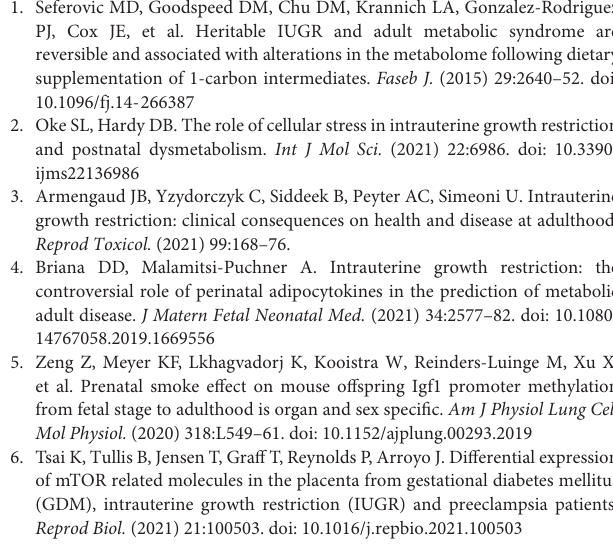
Supplementary Figure 2 | The GO enrichment analysis of the DEGs (RR_3_Mal vs. RC_3_Mal) in the cardiac muscle samples of the rats. (A) The GO enrichment analysis of upregulated DEGs in RR_3_Mal and downregulated in RC_3_Mal. (B) The GO enrichment analysis of downregulated DEGs in RR_3_Mal and upregulated in RC_3_Mal. Supplementary Figure 3 | The GO and KEGG enrichment analysis of the DEGs (RR_3_Mal vs. RR_9_Mal) in the cardiac muscle samples of the rats. (A) The GO enrichment analysis of upregulated DEGs in RR_3_Mal and downregulated DEGs in RR_9_Mal. (B) The GO enrichment analysis of downregulated DEGs in RR_3_Mal and upregulated DEGs in RR_9_Mal. (C) The KEGG enrichment analysis of upregulated DEGs in RR_3_Mal and downregulated DEGs in RR_9_Mal. (D) The KEGG enrichment analysis of downregulated DEGs in RR_3_Mal and upregulated DEGs in RR_9_Mal. Supplementary Figure 4 | The GO and KEGG analysis of the DEGs (RC_9_Ob vs. CC_9_Ob) in the skeletal muscle samples of the rats. (A) The GO enrichment analysis of upregulated DEGs in RC_9_Ob and downregulated DEGs in CC_9_Ob. (B) The GO enrichment analysis of downregulated DEGs in RC_9_Ob and upregulated in CC_9_Ob. (C) The KEGG enrichment analysis of upregulated DEGs in RC_9_Ob and downregulated DEGs in CC_9_Ob. (D) The KEGG enrichment analysis of downregulated DEGs in RC_9_Ob and upregulated in CC_9_Ob. Supplementary Figure 5 | The GO and KEGG analysis of the DEGs (RR_3_Mal vs. RC_3_Mal) in the skeletal muscle samples of the rats. (A) The GO enrichment analysis of upregulated DEGs in RR_3_Mal and downregulated DEGs in RC_3_Mal. (B) The GO enrichment analysis of downregulated DEGs in RR_3_Mal and upregulated DEGs in RC_3_Mal. (C) The KEGG enrichment analysis of upregulated DEGs in RR_3_Mal and downregulated DEGs in RC_3_Mal. (D) The KEGG enrichment analysis of downregulated DEGs in RR_3_Mal and upregulated DEGs in RC_3_Mal. Supplementary Figure 6 | The GO and KEGG analysis of the DEGs (RR_3_Mal vs. RR_9_Mal) in the skeletal muscle samples of the rats. (A) The GO enrichment analysis of upregulated DEGs in RR_3_Mal and downregulated DEGs in RR_9_Mal. (B) The GO enrichment analysis of downregulated DEGs in RR_3_Mal and upregulated DEGs in RR_9_Mal. (C) The KEGG enrichment analysis of upregulated DEGs in RR_3_Mal and downregulated DEGs in RR_9_Mal. (D) The KEGG enrichment analysis of downregulated DEGs in RR_3_Mal and upregulated DEGs in RR_9_Mal. (E) The GO tree of 46 metabolism-related DEGs in the metabolic process